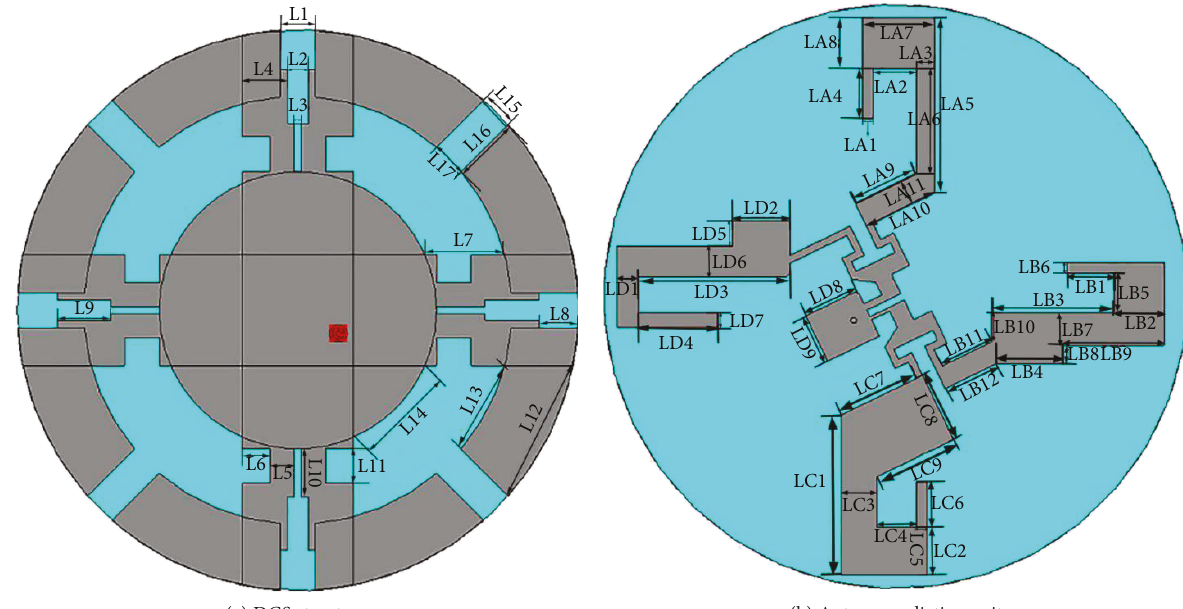
Figure 1: DGS antenna